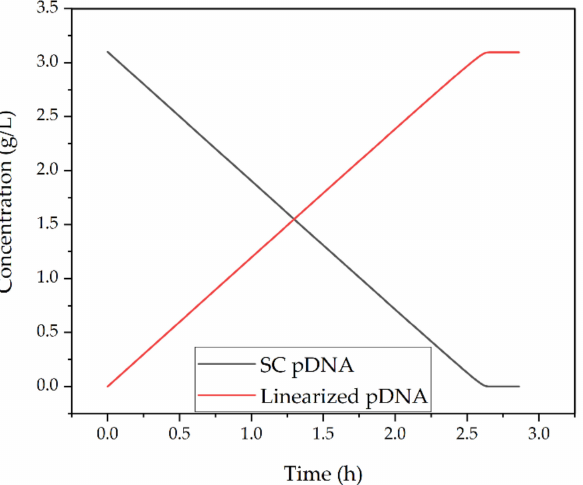
Figure 14. Progression of the linearization reaction over time. The linearization of plasmid DNA is completed after approximately 2.6 h. Reaction time depends on the enzyme used and concentration, as well as desired product concentration and substrate turnover.